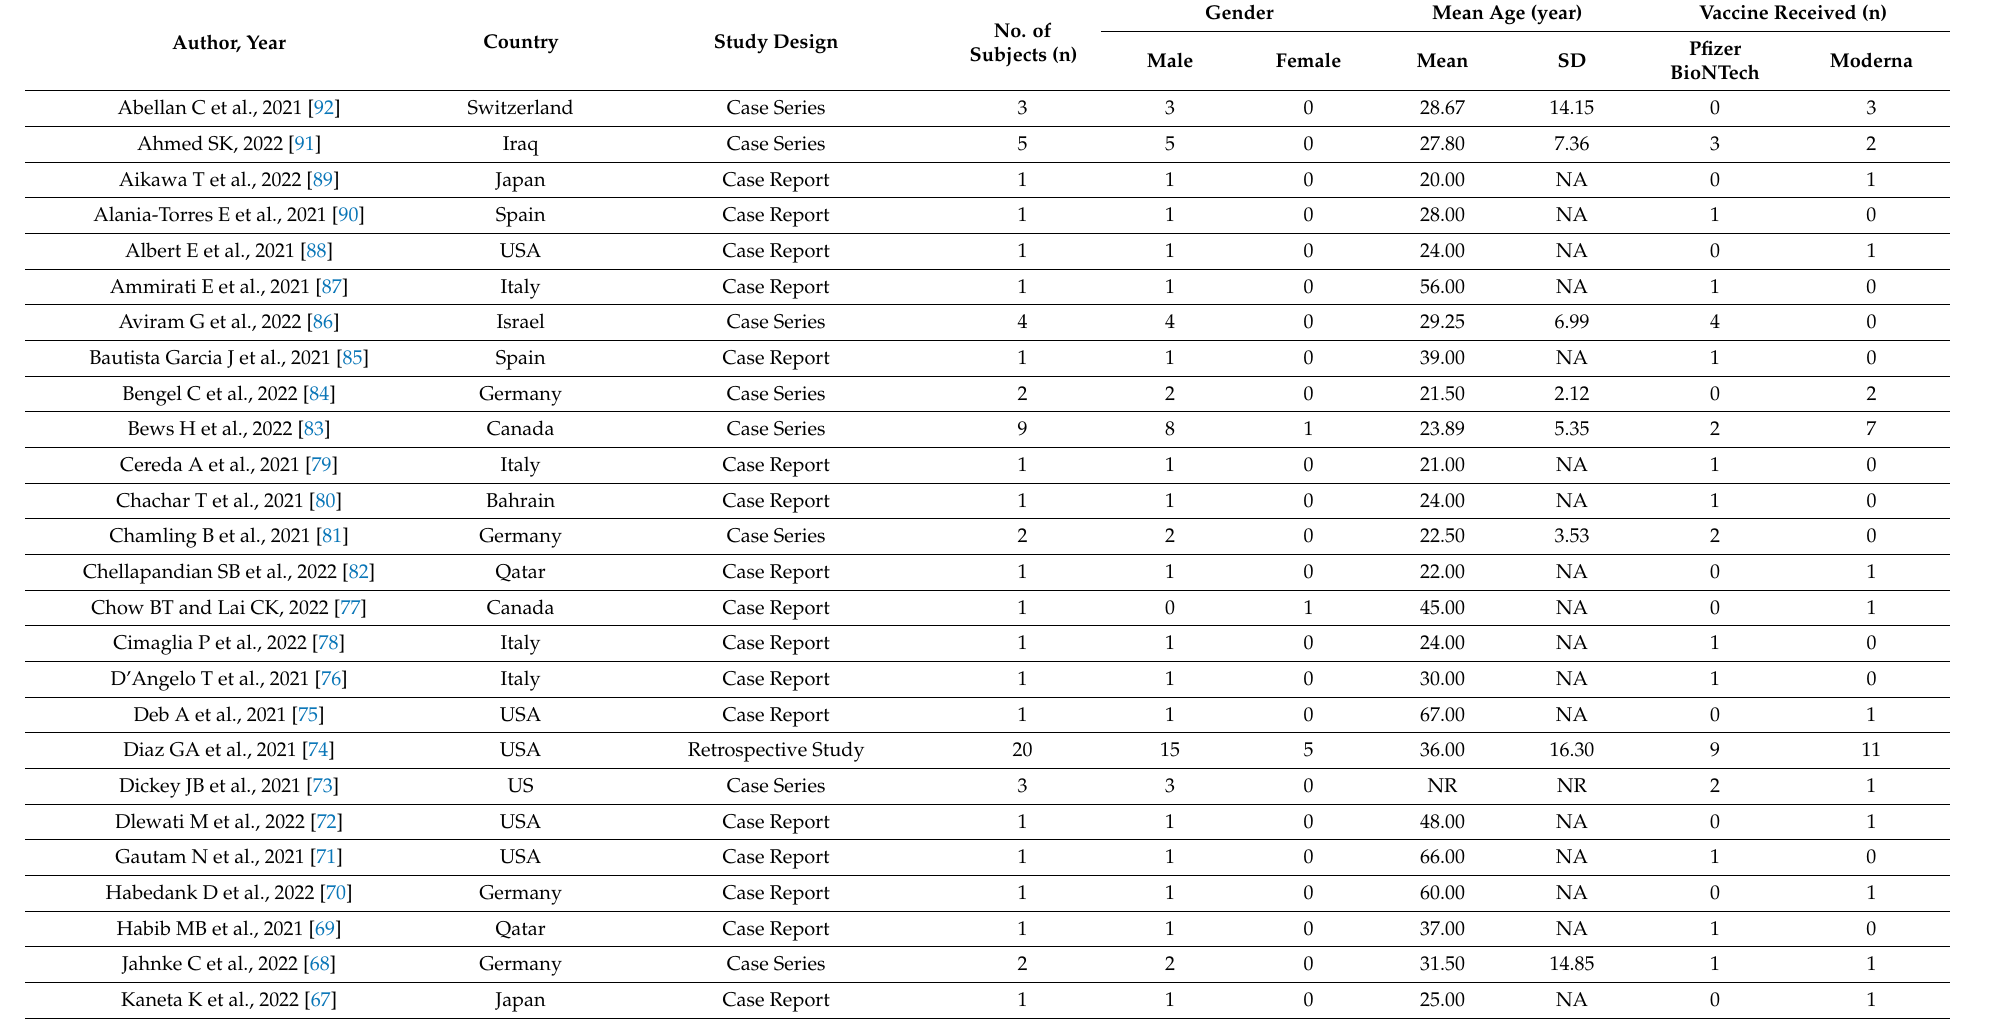
Table 1. Baseline Characteristics of Included Studies